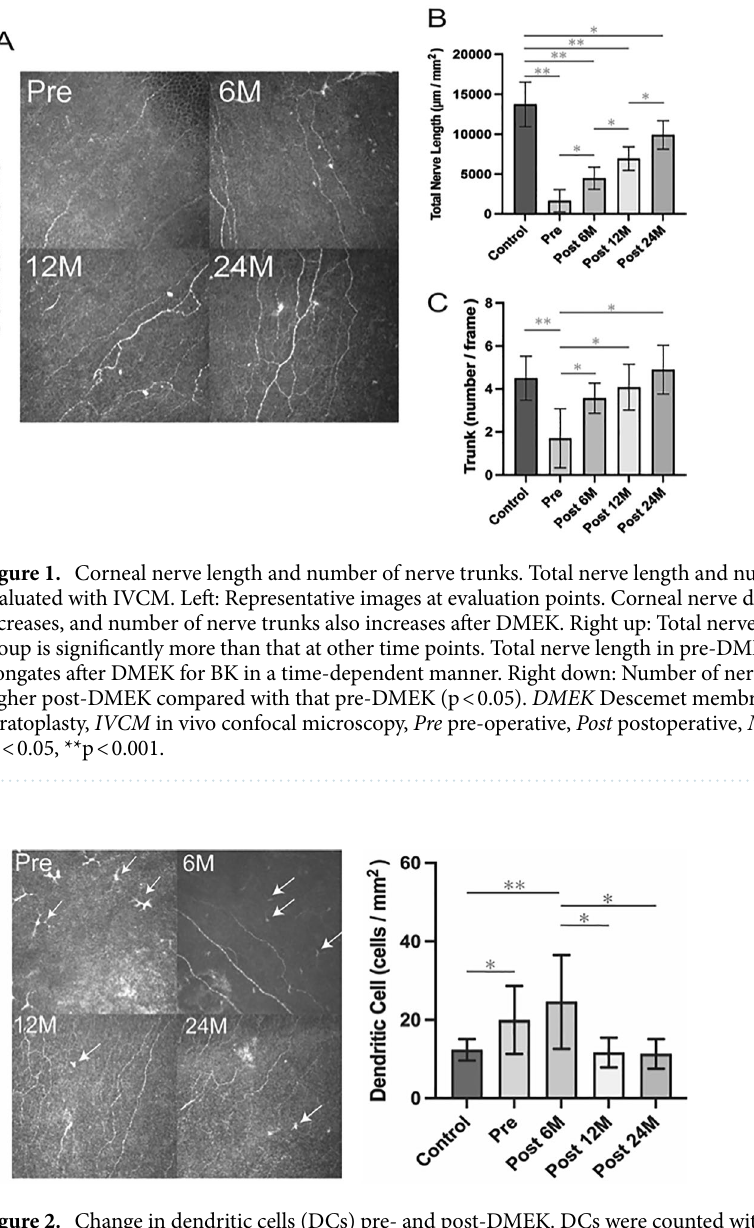
postoperatively (Fig. 1, right down). The number of nerve trunks significantly increased at 6, 12, and 24 months compared to those of the controls (3.6 ± 0.7, 3.7 ± 1.2, 4.9 ± 1.1 number/frame, p = 0.003, 0.017, 0.003, respectively) (Fig. 1, right down). Figure 2 shows the density of DCs over time, represented as images and a graph. The DC density in preopera- tive BK cornea (19.9 ± 8.7 cells/mm 2 ) and postoperatively at 6 months (24.5 ± 11.9 cells/mm 2 ) was significantly higher than that in the controls (12.3 ± 2.7 cells/mm 2 , p = 0.03, p < 0.0001, respectively). It decreased postopera- tively at 12 and 24 months and was significantly lower than that at postoperative 6 months (11.7 ± 3.8 cells/mm 2 , p = 0.003; 11.3 ± 3.8 cells/mm 2 , p = 0.0006, respectively). Moreover, the density of DCs at postoperative 12 and 24 months showed similar values compared to controls. The total nerve length and each endpoint showed a significantly weak correlation (CCT: p = 0.0013, r 2 = 0.31. ECD: p = 0.24, r 2 = 0.0025. Branch: p = 0.0002, r 2 = 0.30, Trunk: p < 0.0001, r 2 = 0.46, DCs: p = 0.0013, r 2 = 0.22,